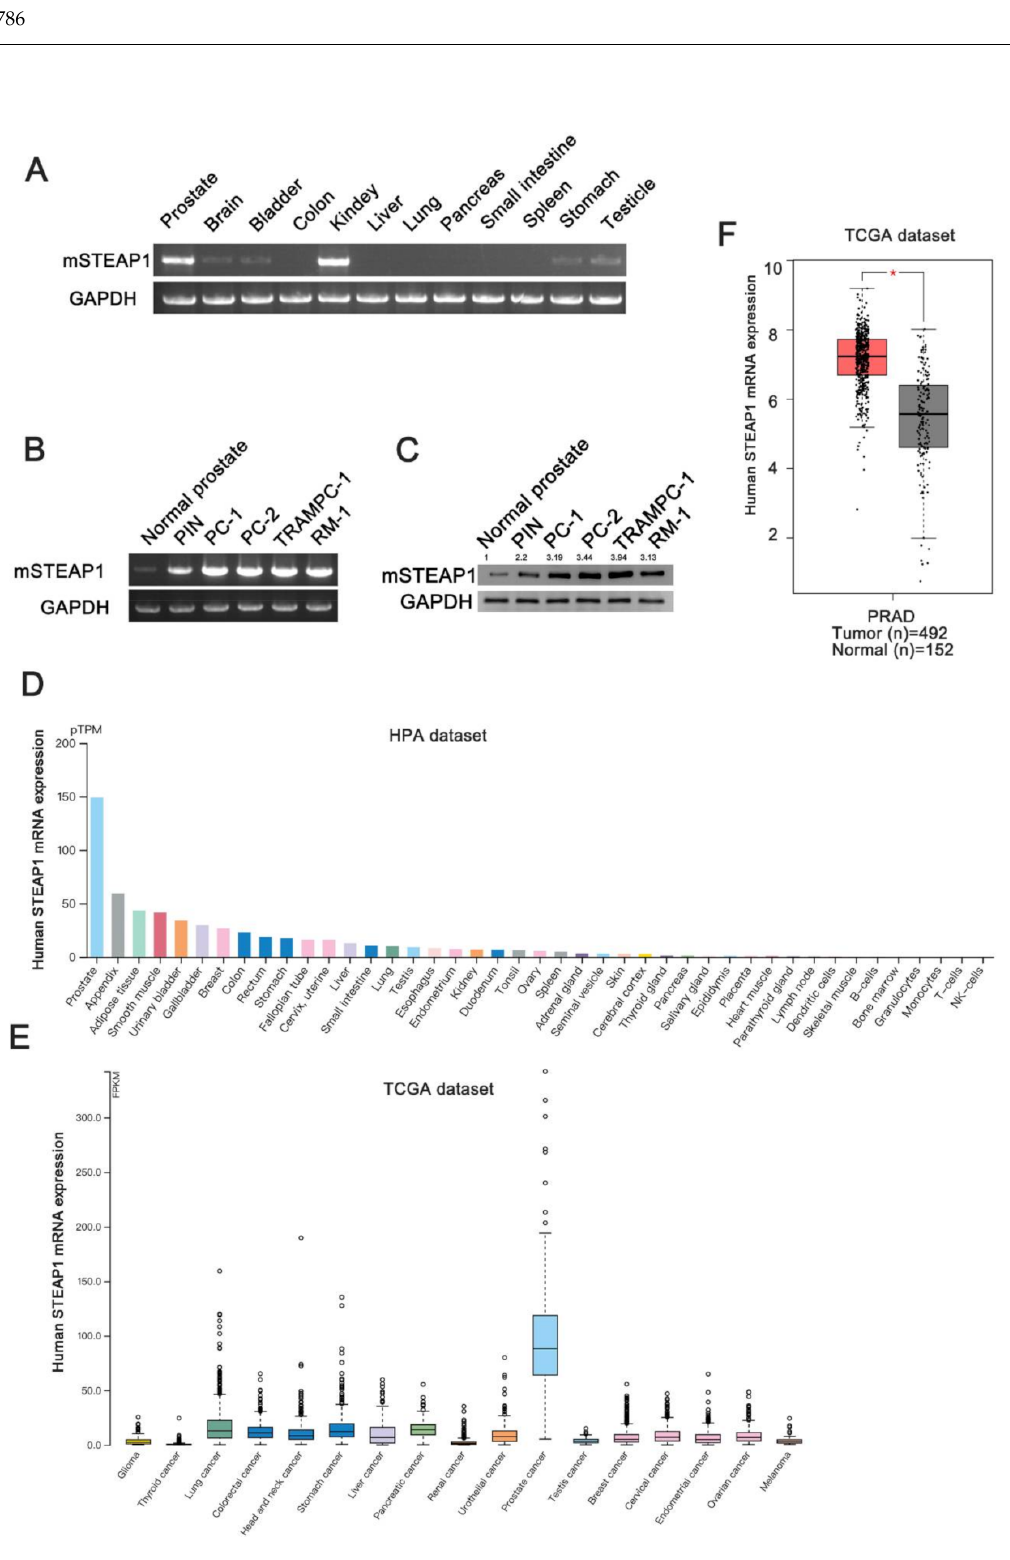
Figure 1. STEAP1 is highly expressed in the prostate cancer and gradually increases as the tumor progresses. ( A ) The mRNA expression of mouse STEAP1 in normal tissues. ( B ) The mRNA expression of mouse STEAP1 in normal prostate, prostatic intraepithelial neoplasia (PIN), prostate cancer (PC, TRAMP mouse), and prostate cancer cells of mouse. All PCR products were separated using 1.5% agarose gel. ( C ) Mouse STEAP1 protein expression in prostate and prostate cancer cells. ( D ) STEAP1 expression levels in normal human tissues and human cancers ( E ). ( F ) The expression of STEAP1 in human normal prostate and prostate cancer in TCGA database. * p <